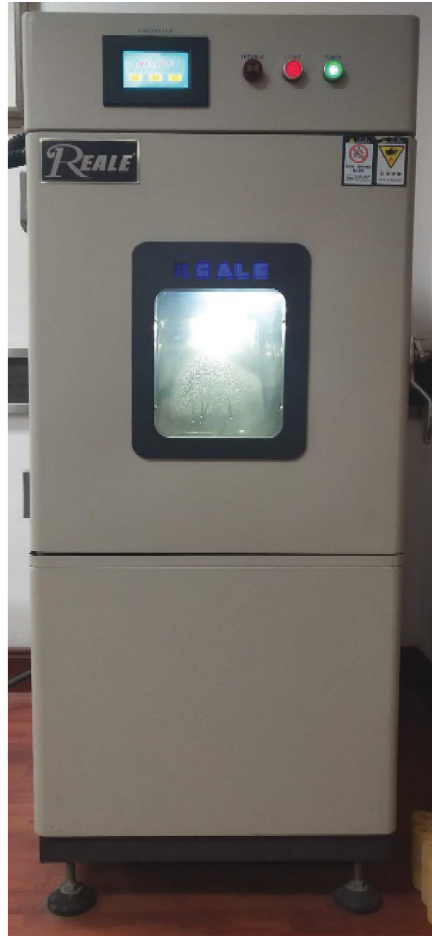
Figure 4: The temperature and humidity chamber.